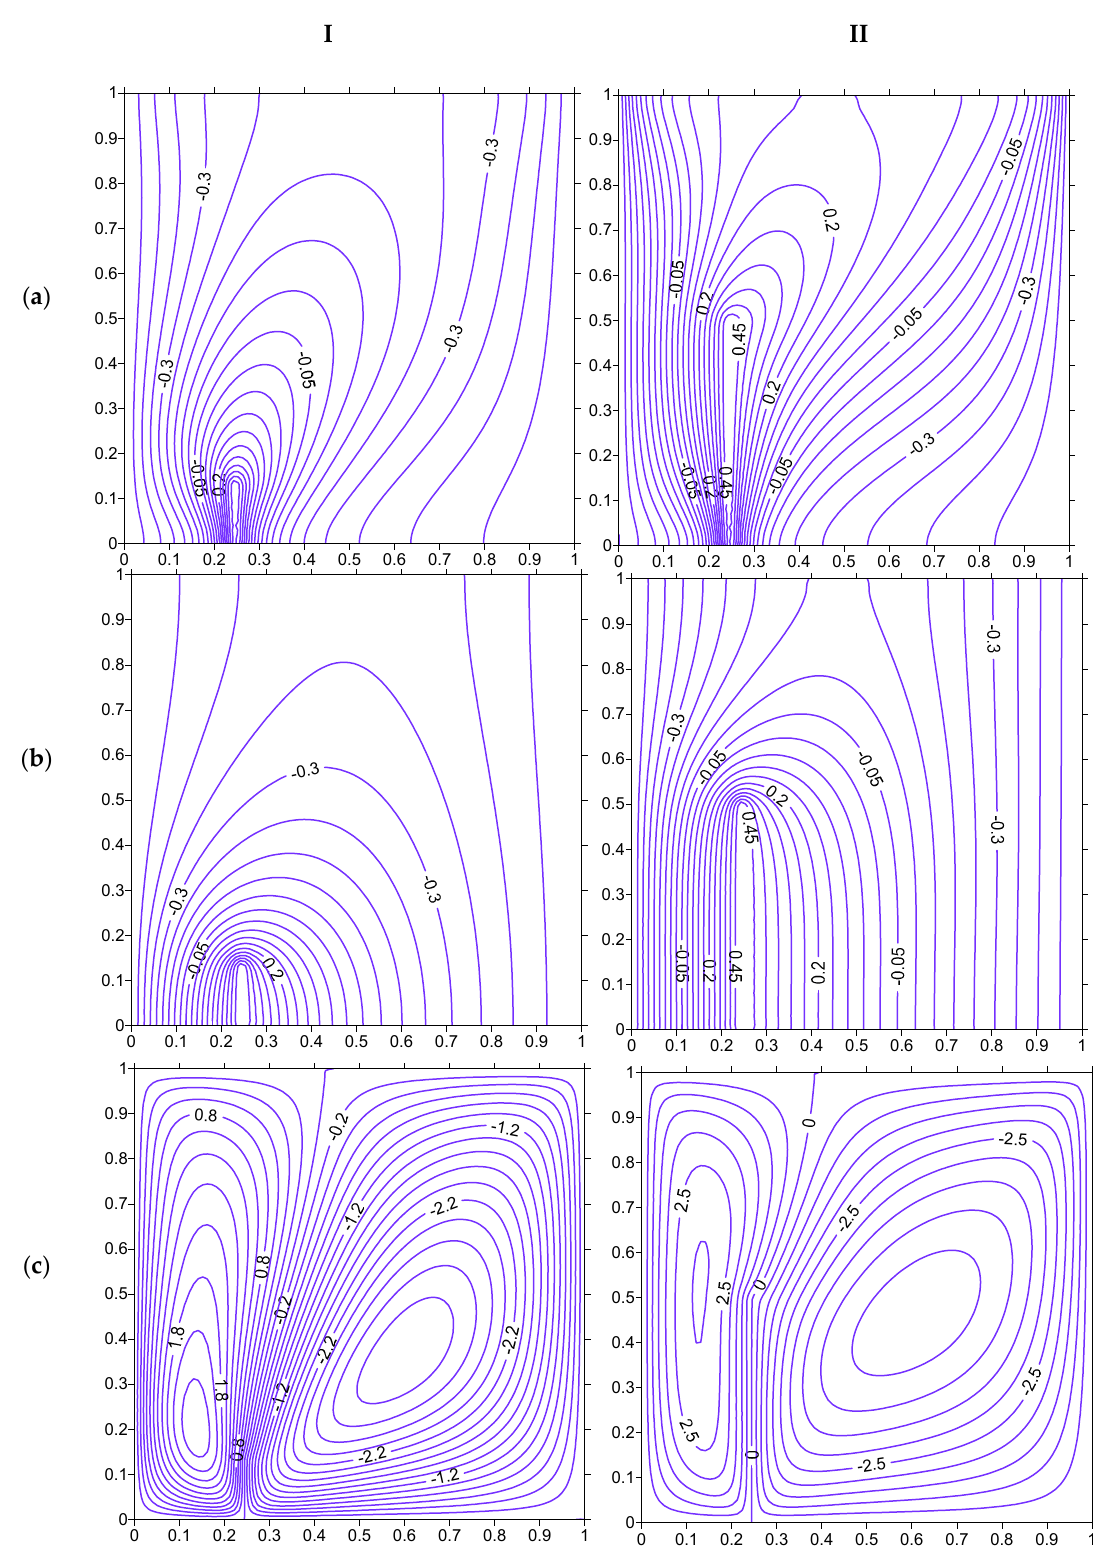
Figure 8. Isotherms (( a ) Fluid, ( b ) Solid) and streamlines ( c ), at Ra = 100, H = 5, Kr = 1, Rd = 0 for strip at x = 0.25. ( I ) HH = 12.5%. ( II ) HH =